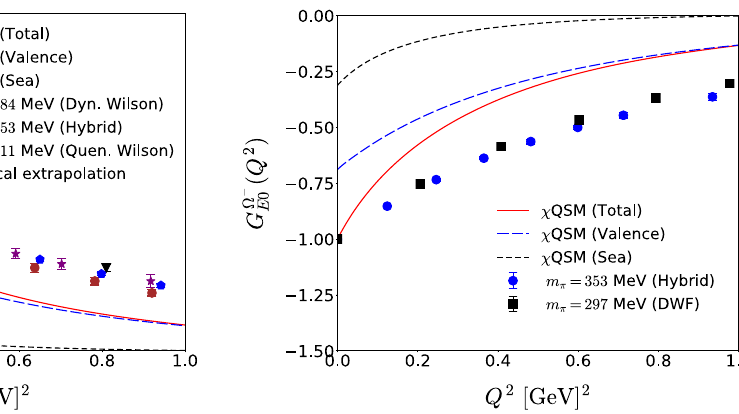
Fig. 1 Contributions of the valence and sea quarks to the electric monopole form factors of the (cid:2) + isobar and (cid:5) − in the left and right panels, respectively. The dashed curves depict the valence-quark con- tributions, the short-dashed ones draw those of the sea quarks, and the solid ones show the total results. The lattice data are taken from Refs.